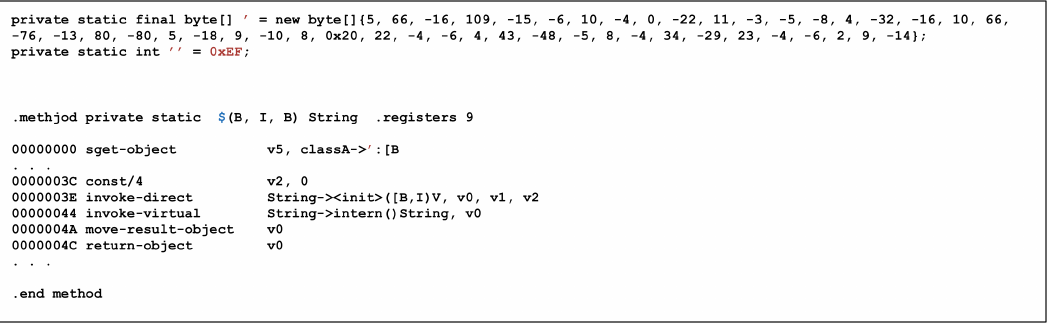
Figure 20. Disassembled Class->$(B,I,B)